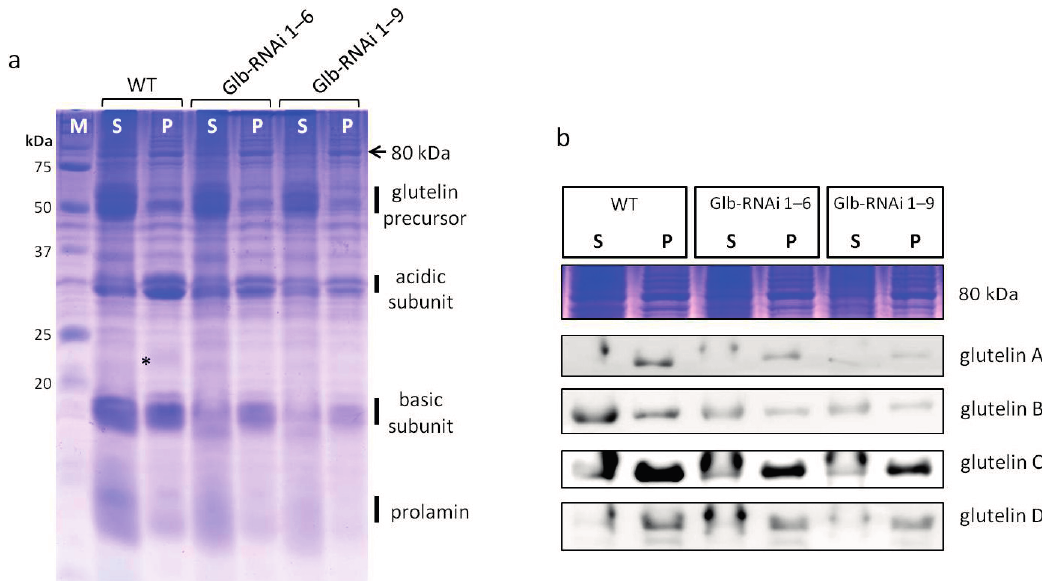
Figure 4. Extraction patterns of storage proteins from wild type (WT) and Glb-RNAi lines. ( a ) Proteins isolated in the absence (S) or presence (P) of β -ME were resolved on an SDS-PAGE gel and stained with CBB solution. M, unstained protein standard marker (Bio-Rad, #161-0363); *, globulins; ( b ) Proteins were transferred to polyvinylidene difluoride (PVDF) membranes and antibodies directed against various glutelins were used to detect the accumulated glutelin acidic proteins. CBB-stained protein band at approximately 80 kDa indicates the internal loading control. S, supernatant; P,